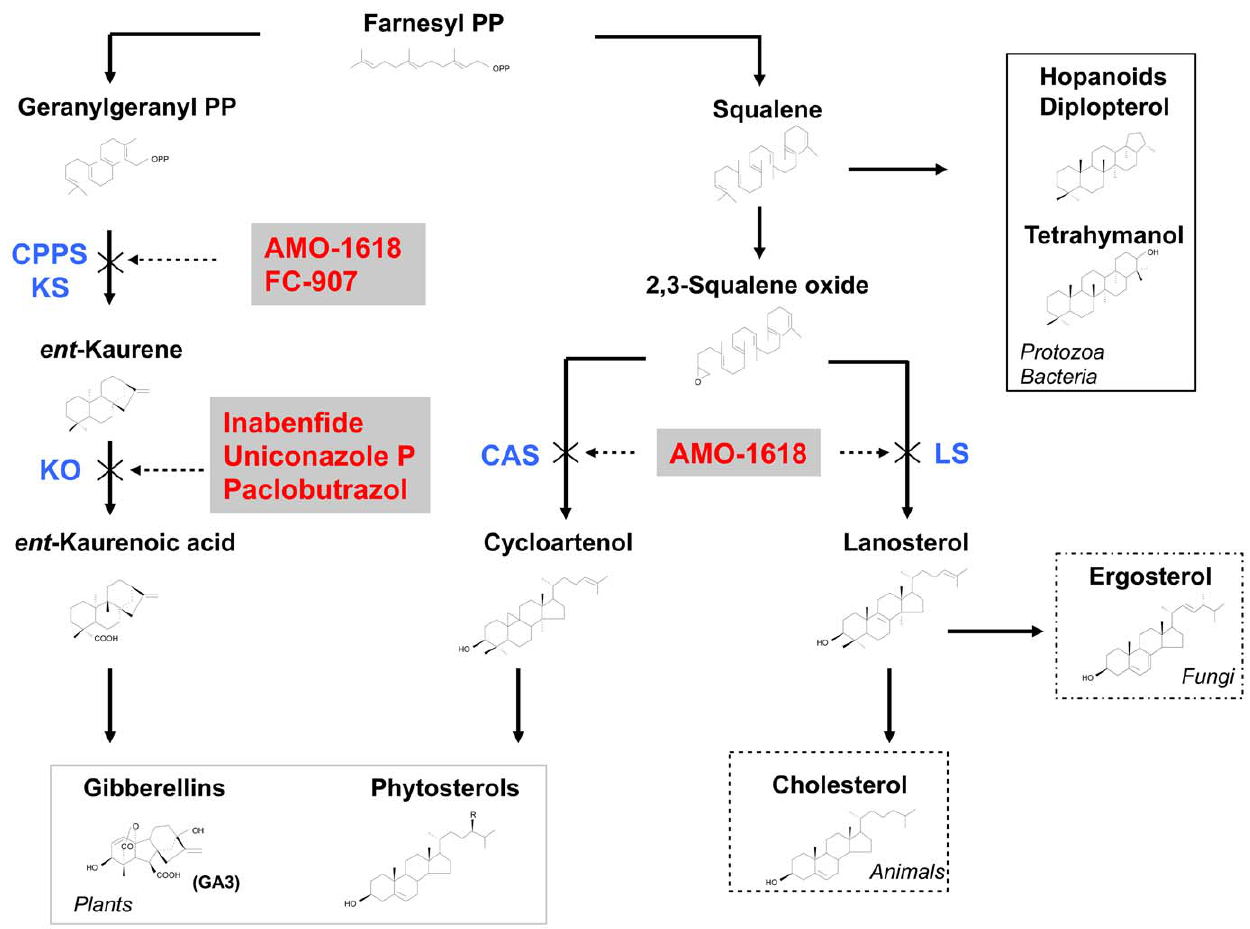
Figure 1. Isoprenoid biosynthetic pathways and known inhibitors in various organisms. Broken arrows indicate blocks in the biosynthesis due to specific inhibitors. ‘‘R’’ indicates various functional groups specific to individual compounds. CPPS, copalyl-diphosphate synthase (EC 5.5.1.13); KO, ent -kaurene oxidase (EC 1.14.13.78); CAS, cycloartenol synthase (EC 5.4.99.8); LS, lanosterol synthase (EC 5.4.99.7); KS, ent -kaurene synthase (EC 4.2.3.19); PP, pyrophosphate.